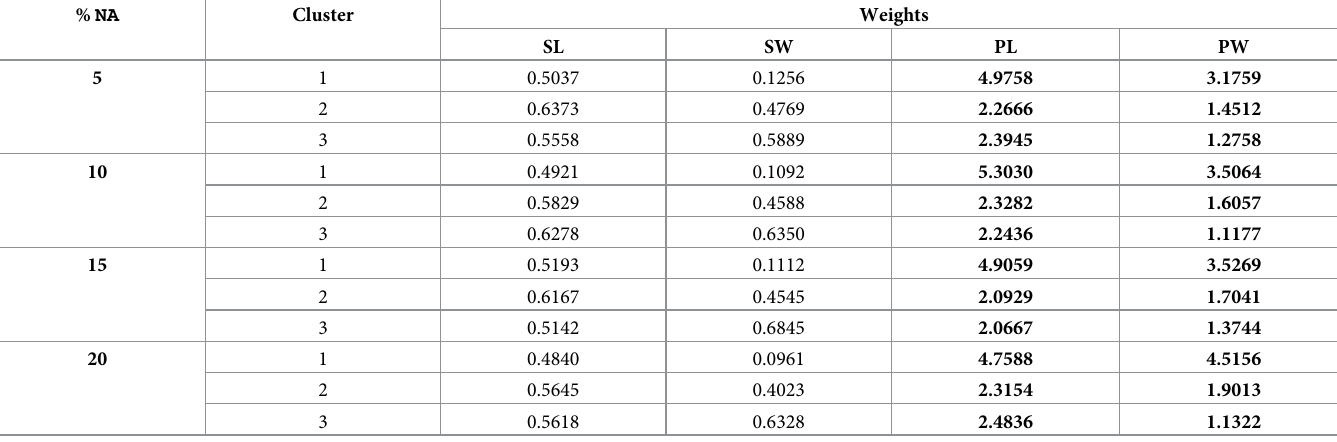
Table 3. Weights of the variables in each group adjusted by the VKFCM-K-LP algorithm with the WDS strategy under different percentages of missing